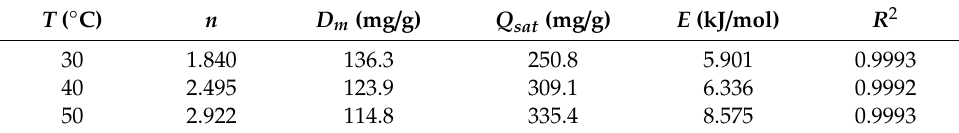
Figure 8. The adsorption isotherms of RhB on WSO-5 at pH 6. (30, 40 and 50 ◦ C). Table 1. The parameters of the monolayer adsorption model under different tested temperatures.